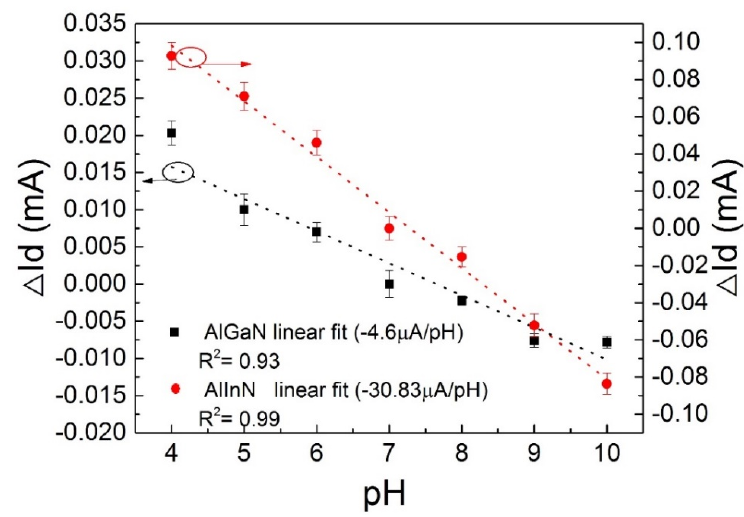
Figure 4. The current variation (∆ I ds ) as a function of pH and linear fits for the AlInN/GaN and AlGa/GaN heterostructure devices; the V ds fix to 1 V.